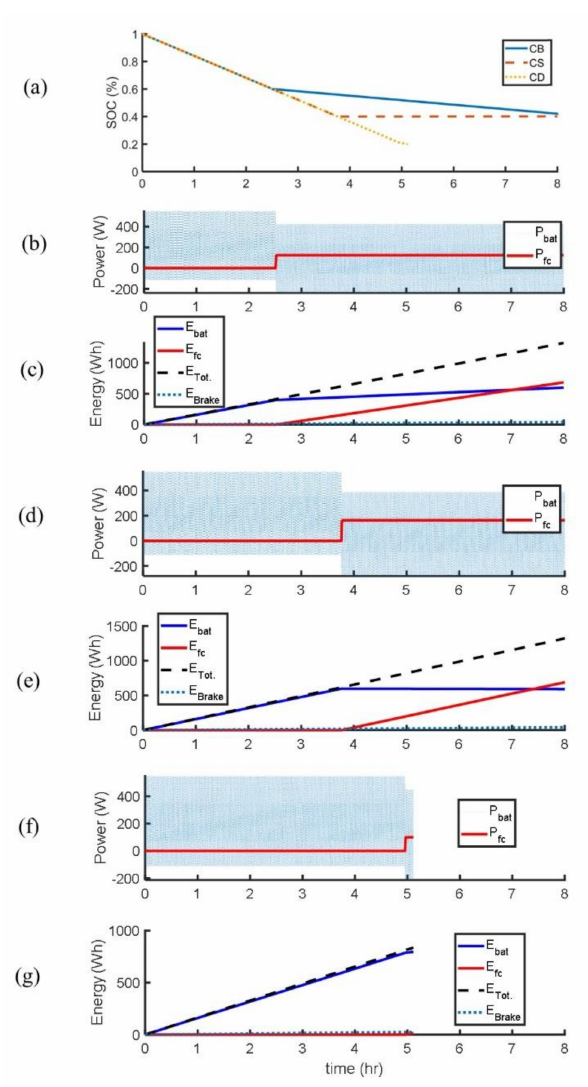
Figure 12. ( a ) Battery SOC levels with the three strategies, ( b ) battery and FC power in the CB strategy, ( c ) provided energy by each energy sources during CB strategy, ( d ) battery and FC power in the CS strategy, ( e ) provided energy by each energy sources during CS strategy, ( f ) battery and FC power in the CD strategy, and ( g ) provided energy by each energy sources during the CD